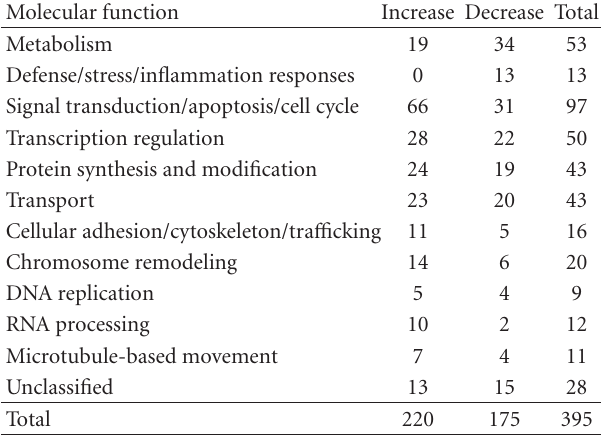
Table 4: The numbers of genes di ff erentially expressed in HDcon Mice but normalized or reversed by Chongkukjang consumption (HDC) (1)